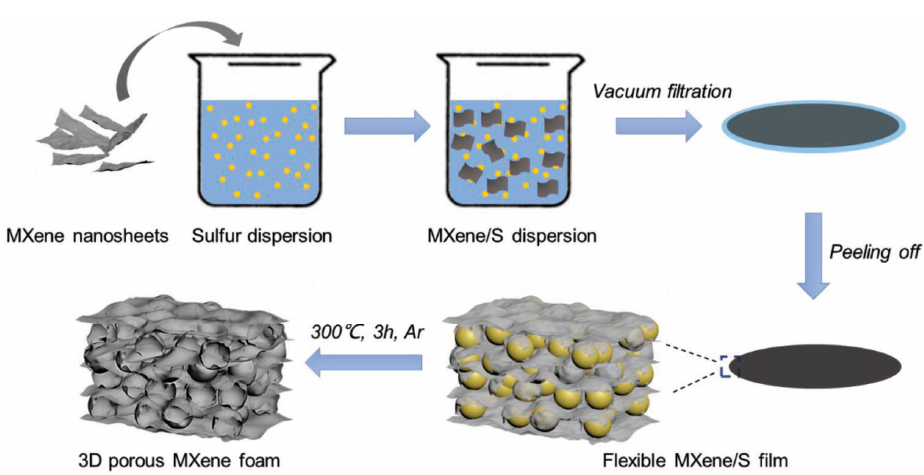
Figure 10. Schematic diagram of 3D porous MXene film synthesis using sacrificial sulfur template; reproduced from [50], with the permission of Wiley-VCH.